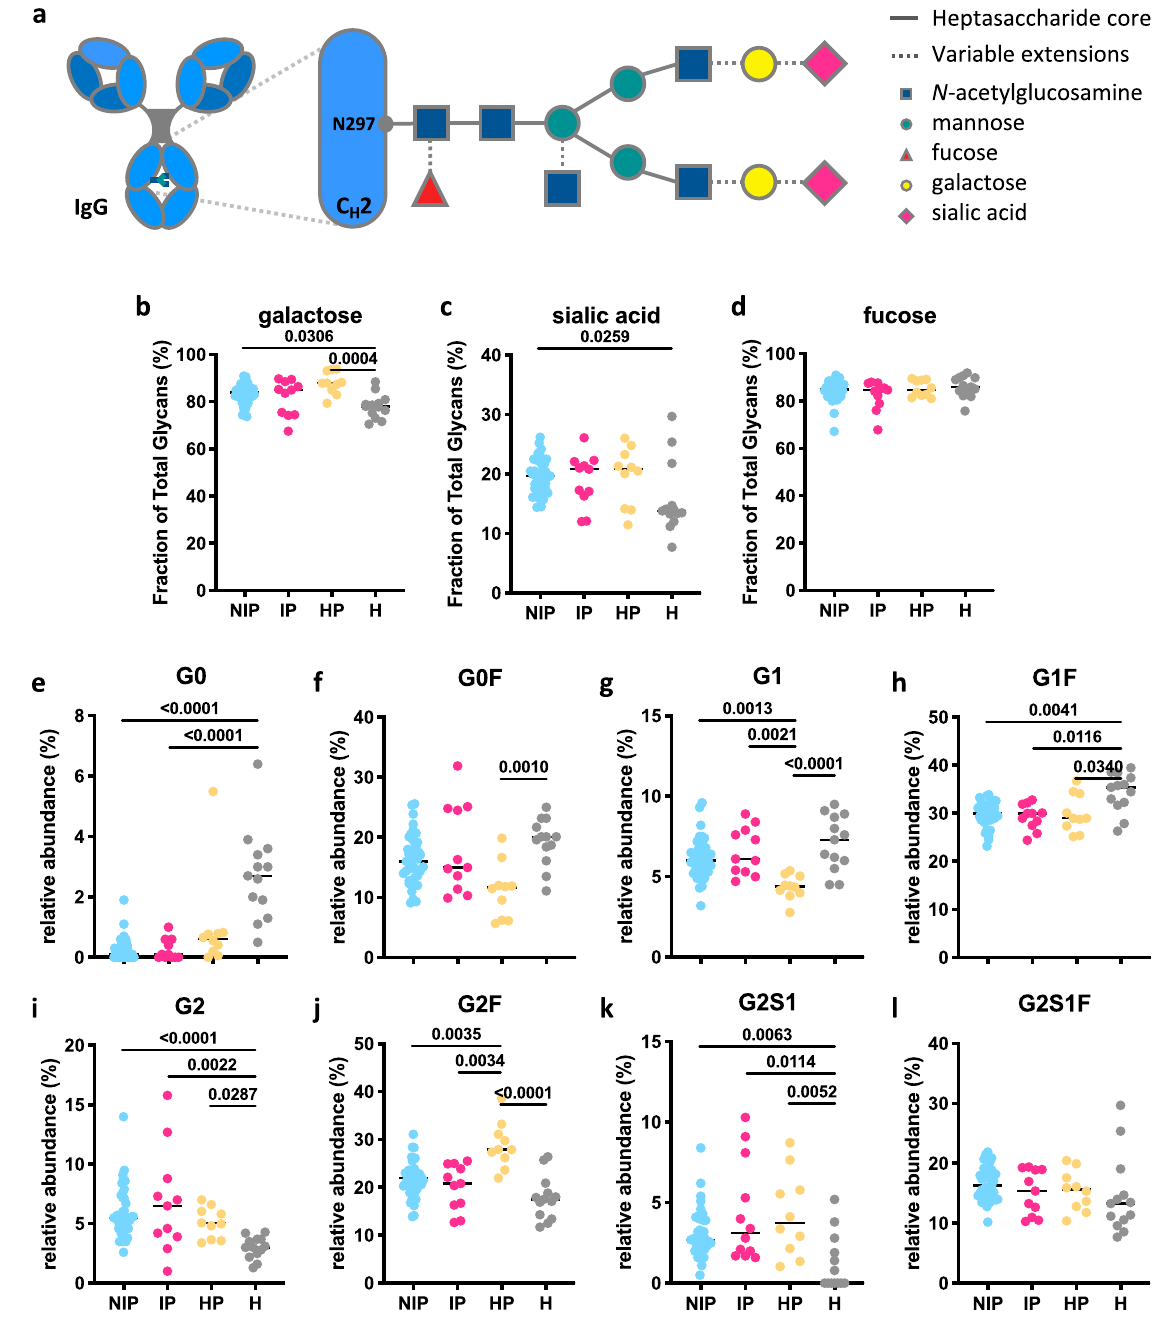
Figure 6. Glycan profiles of IgG Abs in pregnant women with malaria. ( a ) Schematic representation of N -linked glycan composition of human IgG Abs. The glycans are attached to asparagine (N) at position 297 in the C H 2 domain of IgG and have a biantennary heptasaccharide core (solid line) and variable extensions (dash line), such as fucose, galactose and/or sialic acid. Relative abundance of specific types of N -linked glycan structures of purified IgG Abs from non-infected pregnant women (NIP; N = 41; blue), pregnant women with malaria infection (IP; N = 11; pink), malaria-naïve healthy pregnant women (HP; N = 10; yellow) and uninfected healthy non-pregnant women (H; N = 13; grey) were profiled. % of Fc glycans with the presence of ( b ) galactose (monogalactosylated or digalactosylated), ( c ) sialic acid and ( d ) fucose. ( e – l ) The relative prevalence of several major glycan structures ( G0 agalactosylated, G1 monogalactosylated, G2 digalactosylated, F fucosylated, S1 sialylated). Statistical comparison between groups was performed using a Kruskal–Wallis test corrected for multiple comparisons using Dunn’s multiple comparison method (p-values are shown on